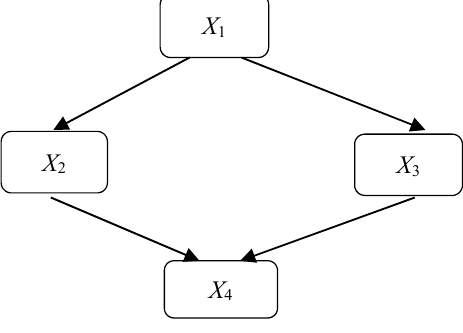
Figure 1. Sample of Bayesian network.